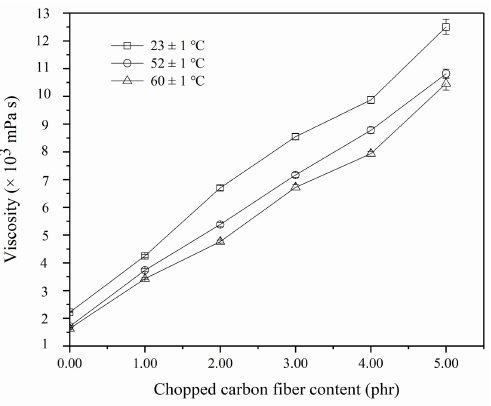
Figure 3. Viscosity changes of resin glue with different content of 6.0 mm chopped carbon